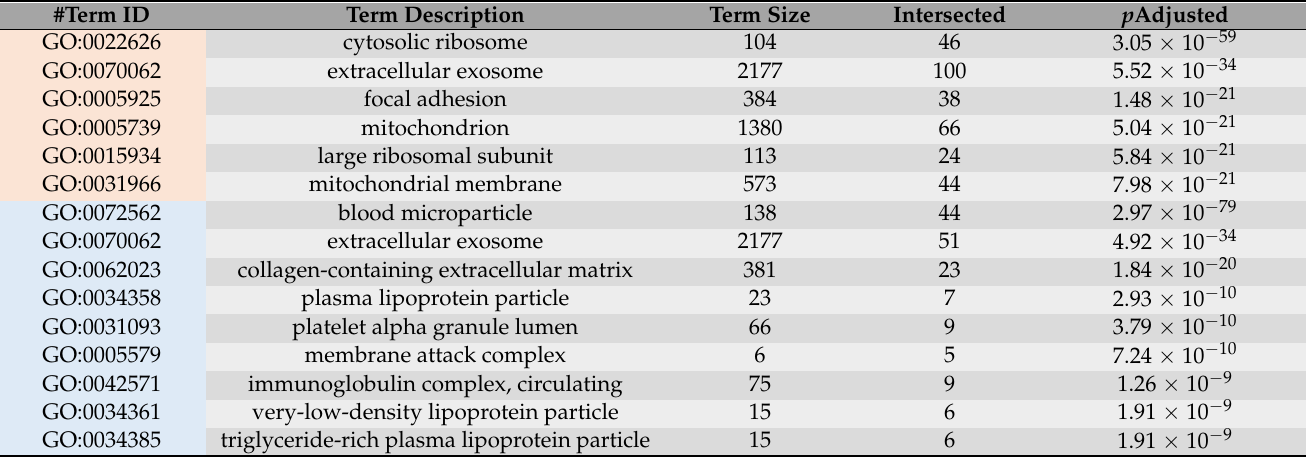
Table 1. GO Cell Component analysis of UC differentially enriched proteins vs. rest of techniques. Red color denotes enrichment in UC preparations, and blue color that the group is